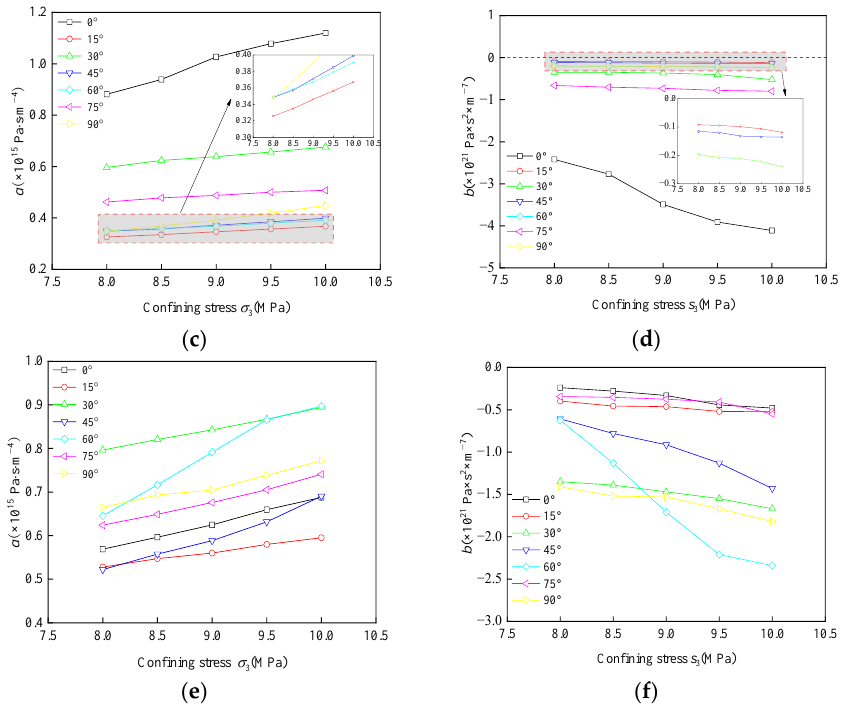
Figure 8. Variation characteristics of Forchheimer’s coefficients with the confining pressure under different inclinations and fractures: ( a ) Variation characteristics of linear term coefficient a of the single fracture; ( b ) variation characteristics of nonlinear term coefficient b of the single fracture; ( c ) variation characteristics of linear term coefficient a of the T-shaped fracture; ( d ) variation characteristics of nonlinear term coefficient b of the T-shaped fracture; ( e ) variation characteristics of linear term coefficient a of the Y-shaped fracture; ( f ) variation characteristics of nonlinear term coefficient b of the Y-shaped fracture.